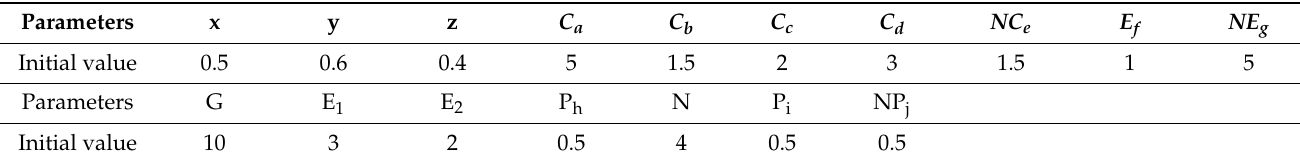
Table 8. Parameter